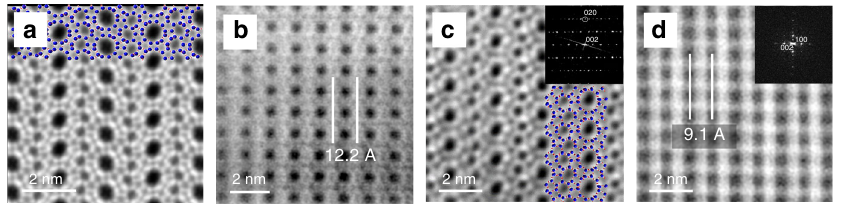
Fig. 3 Comparison of different projections of IWW and IPC-18. C s -corrected STEM-ADF images of IWW ( a , b ) and IPC-18 ( c , d ) zeolites: a , c — top [100] view of the layers, which remain intact during the VPT rearrangement (crystallographic models of the same layer are superimposed for clarity), b , d — side [010] view showing the decrease in interlayer distance caused by the transformation of D4Rs